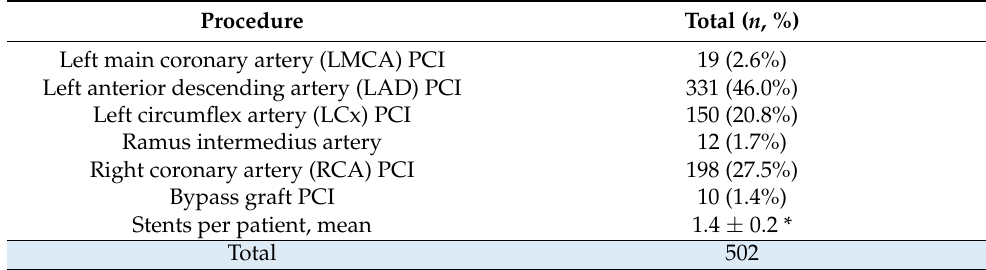
Table 2. Elective PCI target lesions.